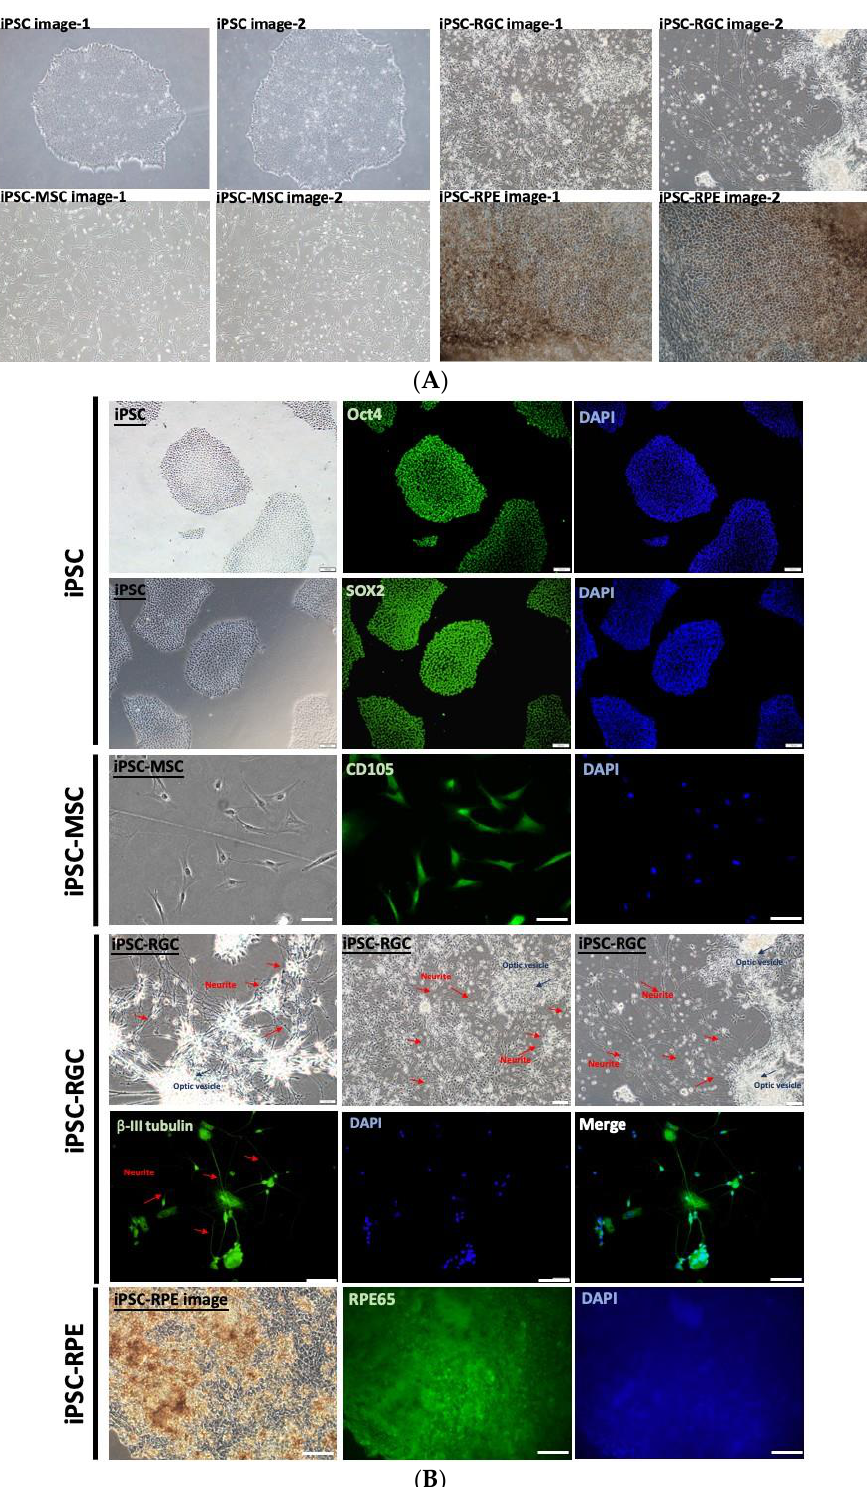
Figure 1. Characterization of iPSCs, iPSC-MSCs, iPSC-RGCs, and iPSC-RPEs with optimal differen- tiation. ( A ) Representative images of iPSCs, iPSC-MSCs, iPSC-RGCs, and iPSC-RPEs obtained by phase-contrast microscopy. ( B ) Validation of the indicated cell types by immunofluorescent staining of the indicated lineage-specific markers. Nuclei stained with DAPI. Scale bars = 100 μm.